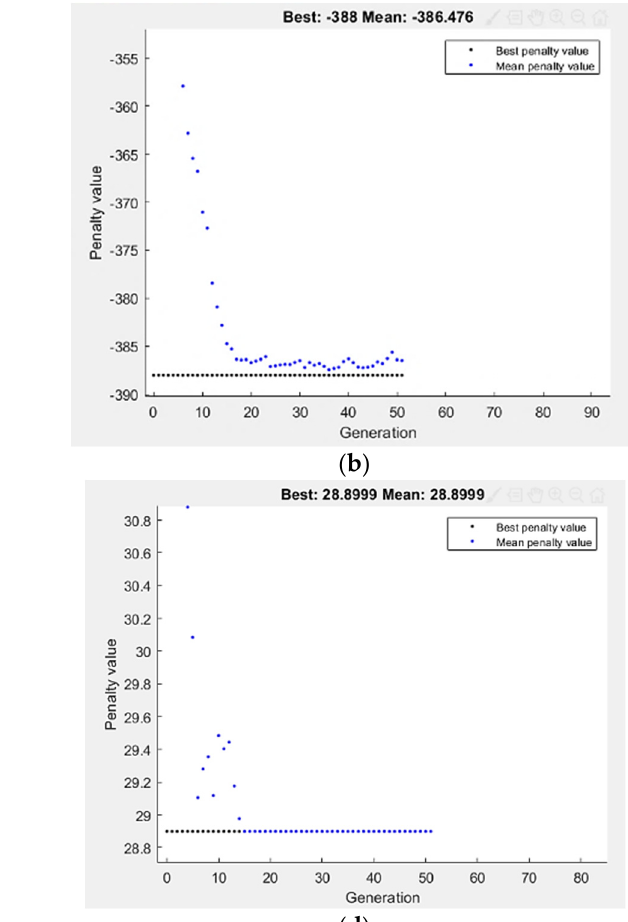
Figure 17. Optimum H C ( a , b ), and H E ( c , d ) by GA ( a , c ), and hybrid RSM-GA ( b , d ).